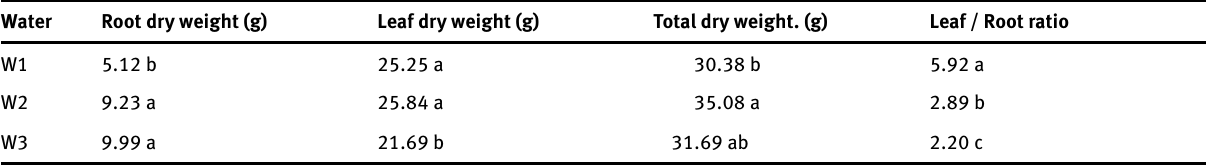
Table 5: Mean values of the tested parameters as affected by different irrigation water quantities